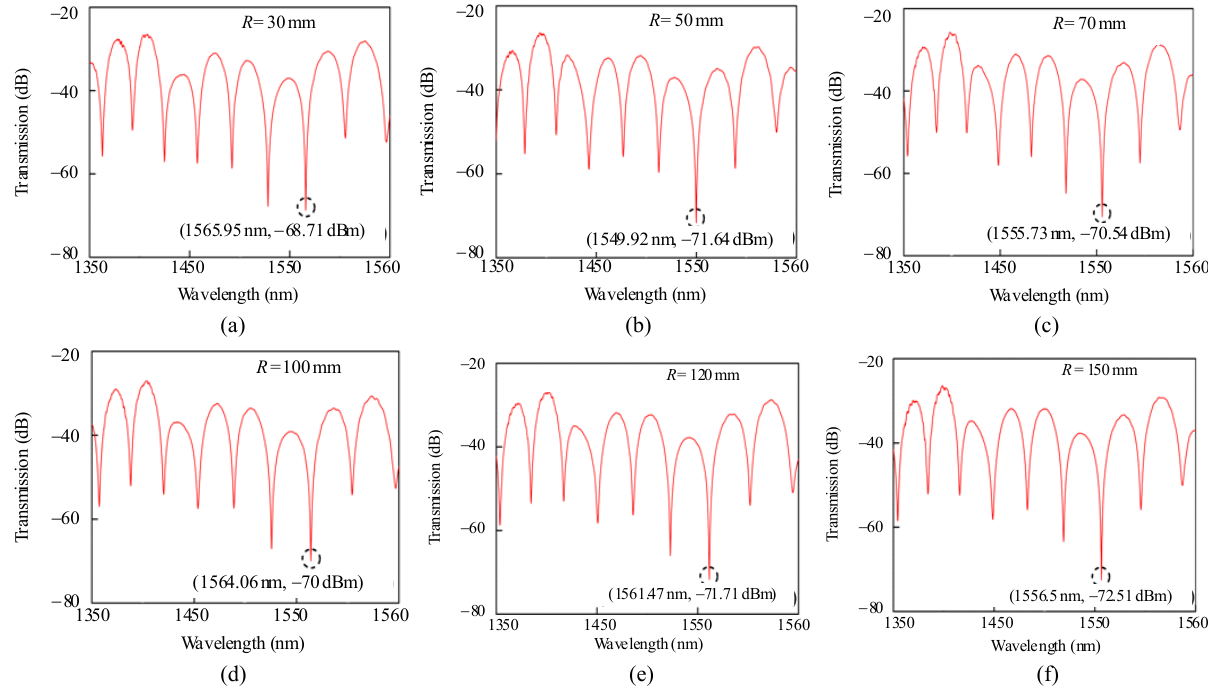
Fig. 5 Transmitted spectra of the PMF-based Sagnac interferometer with different PMF circle radii of (a) 30 mm, (b) 50 mm, (c) 70 mm, (d) 100 mm, (e) 120 mm, and (f) 150 mm at room